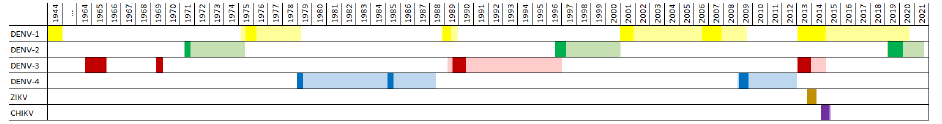
Figure 1. Circulation of the four dengue virus serotypes, Zika virus and chikungunya virus in French Polynesia, 1944–2021. DENV: dengue virus; ZIKV: Zika virus; CHIKV: chikungunya virus. Epidemic and inter-epidemic periods are indicated by bright and pale colors, respectively.